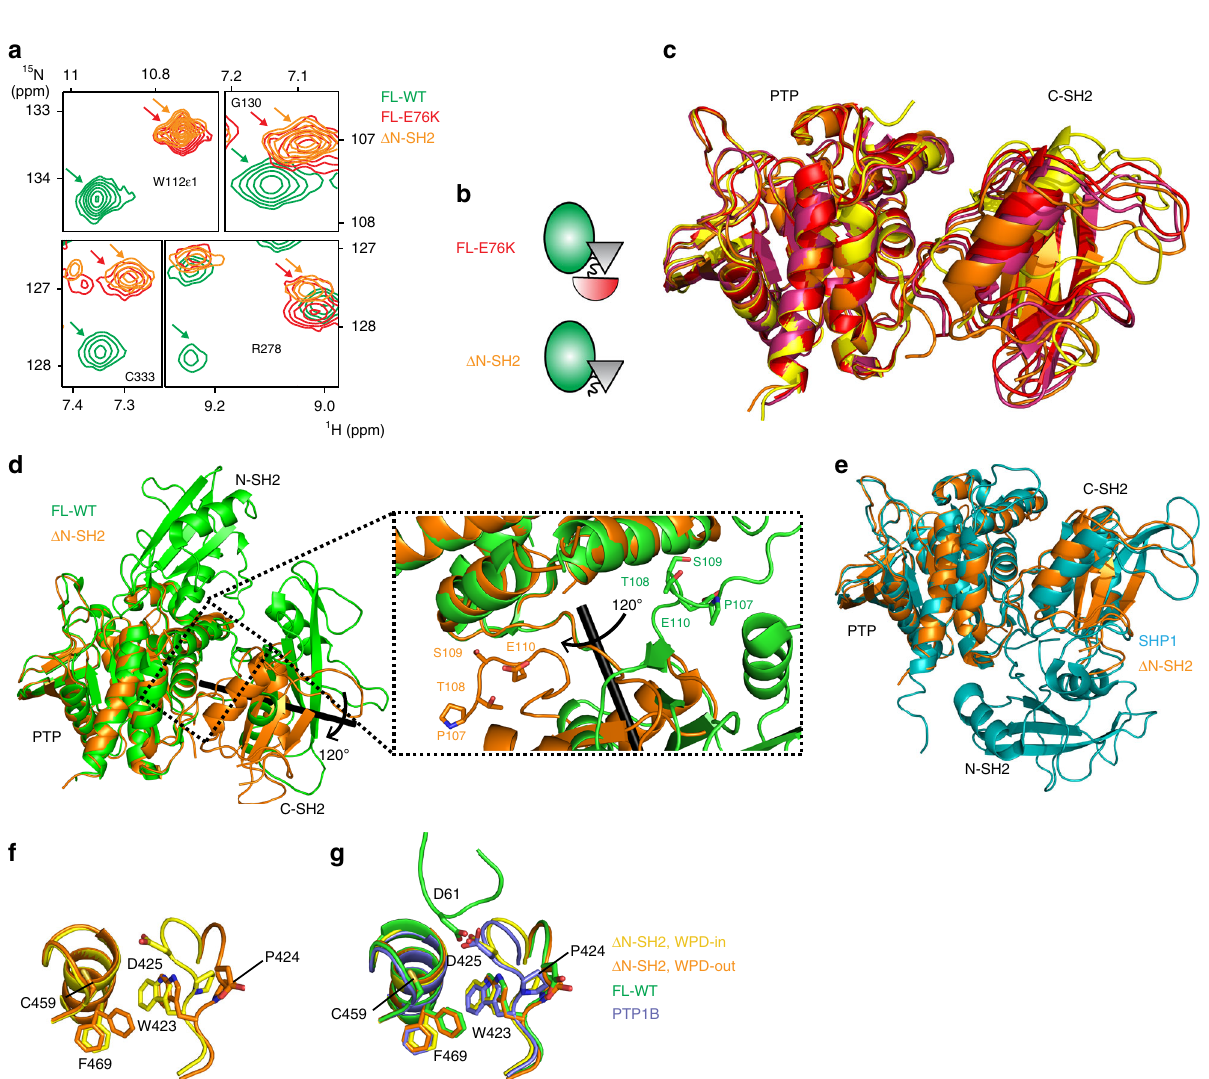
Fig. 2 Structure of the open active state of SHP2. a Chemical shifts of Δ N-SH2 are nearly identical to FL-E76K indicating that removal of the N-SH2 mimics the structure of FL-E76K, shown as cartoon in b . c The four molecules found in the asymmetric unit of the Δ N-SH2 crystal structure (purple, red, orange, yellow) were superimposed using the PTP domain as reference to reveal an ensemble of orientations adopted by the C-SH2 domain. d When compared with FL-WT (green), the C-SH2 domain of the Δ N-SH2 structure (orange) is rotated by 120° (axis in black). This movement positions the SH2-SH2 linker in between the PTP domain and the C-SH2 as exempli fi ed by residues P107-E110 (inset). e The C-SH2 domain in the Δ N-SH2 open structure (orange) adopts a similar conformation to the C-SH2 in the open state of SHP1 (PDB 3ps5, teal) 21 . f Zoom-in of the active site of Δ N-SH2: conformational sampling of the WPD-in (yellow) and WPD-out states (orange, seen in all previous SHP2 structures). g The N-SH2 loop from FL-WT (green) can only dock into the PTP domain when the WPD is in the out conformation. The WPD-in conformation of Δ N-SH2 crystal structure is identical to the one reported for the PTP1B (PDB 1sug, blue) 24 = 95.3 Å) than FL-WT ( R = 26.85 ± 0.43 Å, D = 88.7 Å, the N-SH2 is detached from the PTP (Supplementary Fig. 4a, b) g max fi ts better to FL-E76K SAXS data ( χ = 1.59) compared with the Supplementary Fig. 4e-g), which is consistent with previously crystallized “ open conformation ” of SHP1 ( χ = 2.82) (Supple- reported changes in SHP2 SAXS structural parameters caused by mentary Fig. 4c, d). FL-E76K in solution has a bigger radius of other gain-of-function mutations 17 . In addition, the scattering gyration ( R g = 29.10 ± 0.62 Å) and maximum dimension ( D max experiments on FL-WT agree reasonably well with closed crystal